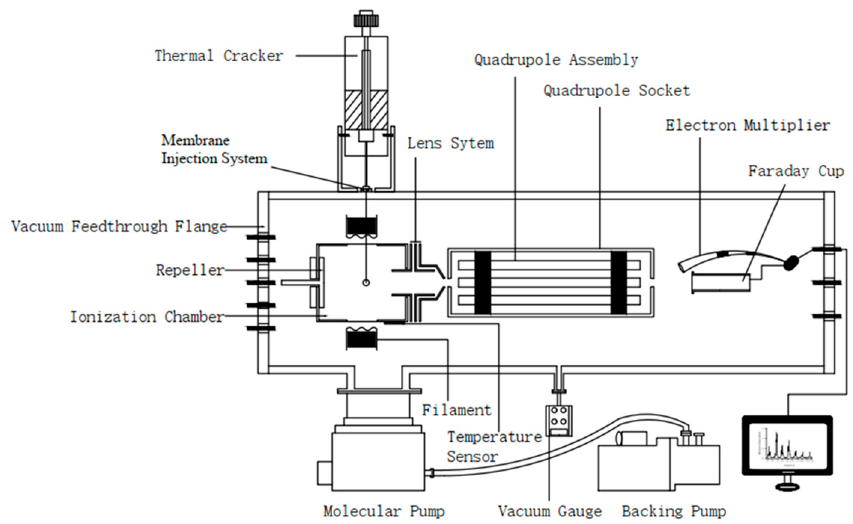
Figure 2. Schematic diagram of the structure of the